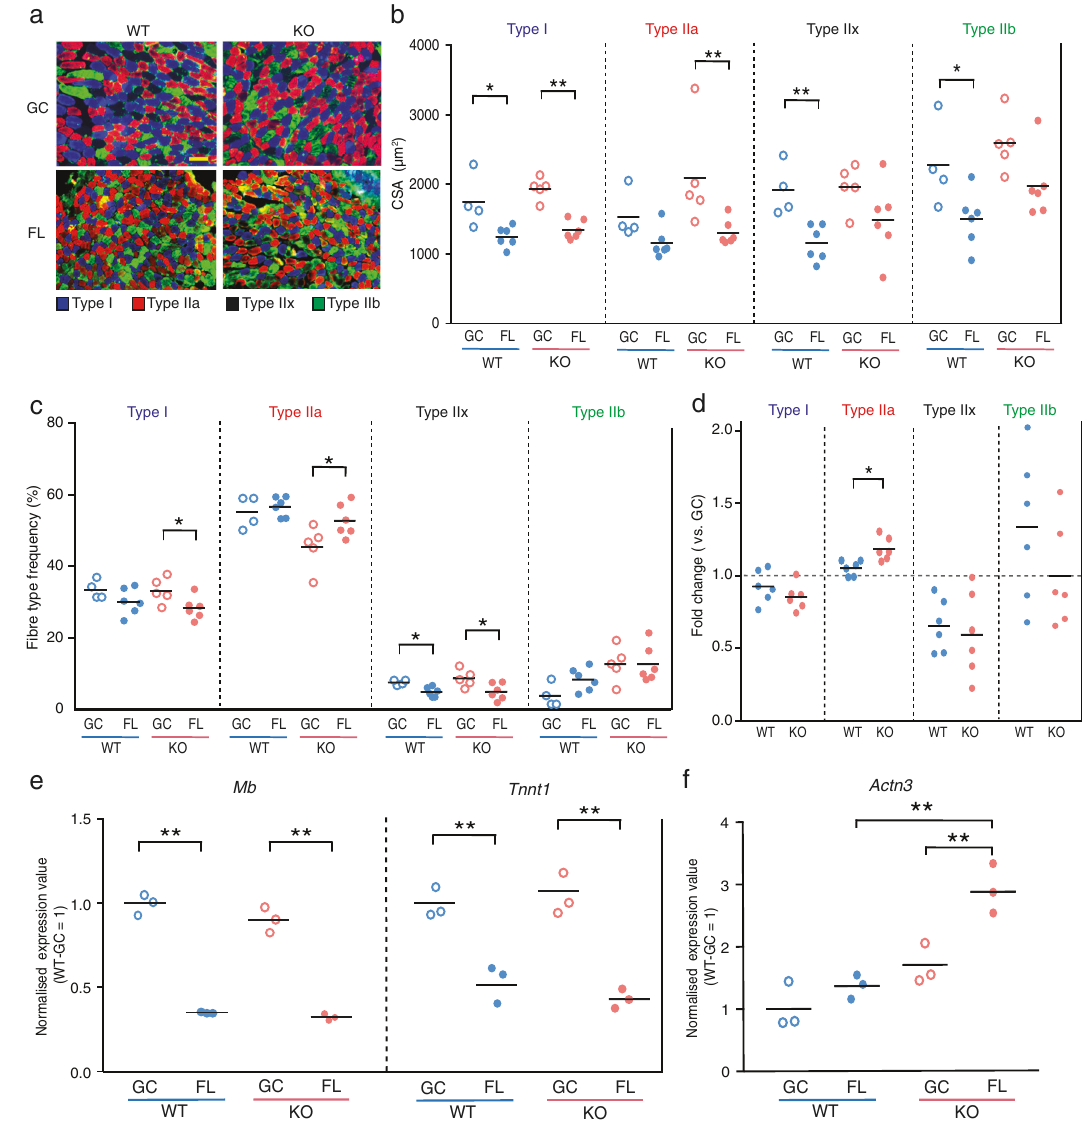
Fig. 5 Effect of Nrf2 de fi ciency on fi bre type transition. a Immunohistochemical staining for myosin heavy chain using BA-D5 (type I; blue), SC-71 (type IIa; red), and BF-F3 (type IIb; green) antibodies. Unstained fi bres predicted to be type IIx (black). Scale bar = 100 μ m. b CSA of each fi bre type from WT-GC ( n = 6), WT-FL ( n = 6), KO-GC ( n = 6) and KO-FL ( n = 6). c Frequency of each fi bre type in WT-GC ( n = 6), WT-FL ( n = 6), KO-GC ( n = 6) and KO-FL ( n = 6) mice. d Comparison of FL fi bre type frequency normalised by GC fi bre type frequency from WT and KO mice. P values from Student ’ s t tests ( b – d ) are indicated as follows: * P < 0.05, ** P < 0.01, GC vs. FL. n = 6 for WT-FL and KO-FL, n = 5 for KO-GC and n = 4 for WT-GC. e Expression of Mb and Tnnt1 in soleus muscles. f Expression value of Actn3 in soleus muscles. Expression values were normalised by Quantile (WT-GC = 1). n = 3 for WT-GC, WT-FL, KO-GC and KO-FL. edgeR test ( e , f ) ** P < 0.01